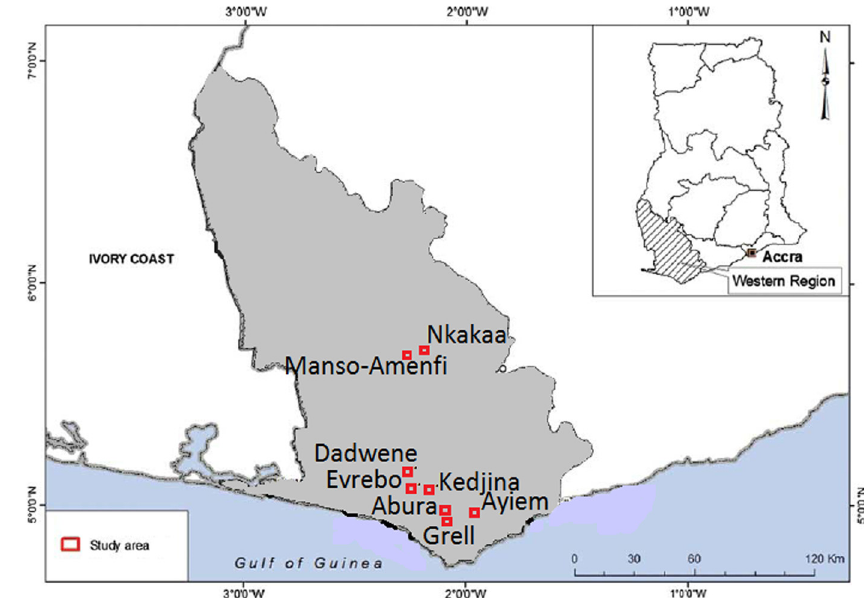
Figure 1: Map of Ghana showing Western Region and the eight selected communities.